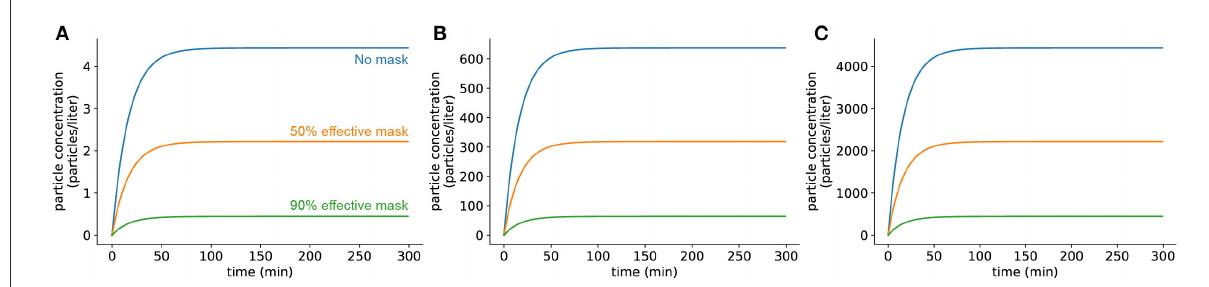
FIGURE1 Viral concentrations in a room with an infected individual present reach steady state quickly. (A) Infected individual with a low viral load strain of virus (similar to the ancestral strain). (B) Individual infected with an intermediate viral load variant (similar to Omicron). (C) Individual infected with a high viral load variant (similar to Delta). Room dimensions are 10 ′ x 20 ′ x 20 ′ . No air filtration or other mitigation methods were used. In all panels, the blue curve shows the concentration when the infected individual has no mask on, the orange curve shows the concentration when the infected individual has on a mask which filters out 50% of exhaled particles (typical cloth mask), and the green curve shows the concentration when the infected individual has on a mask which filters out 90% of exhaled particles (typical surgical mask).